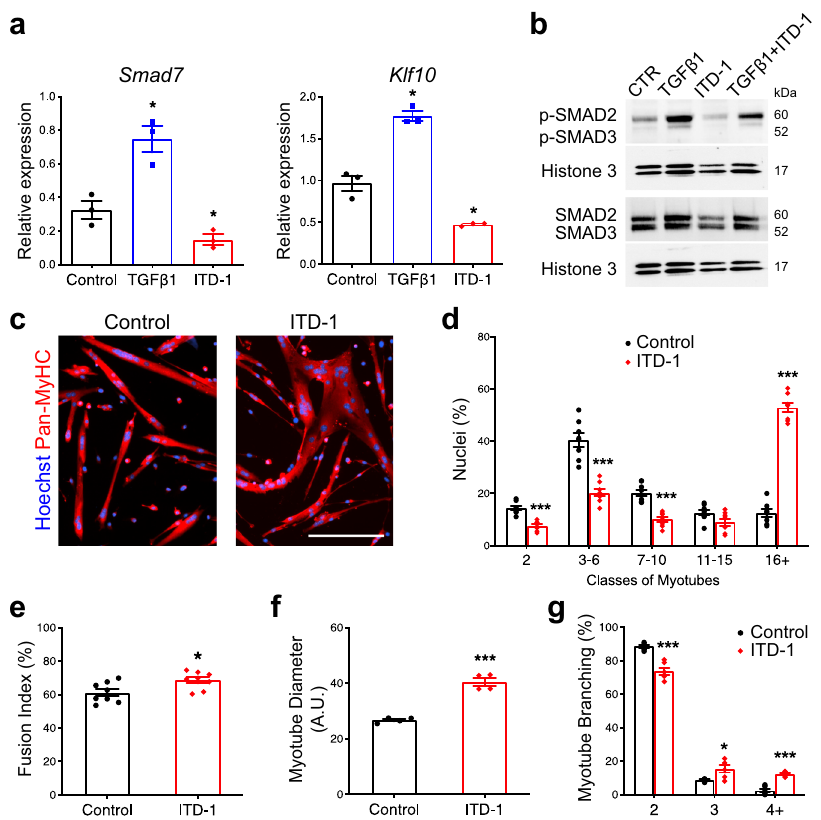
Fig. 5 Inhibition of TGFBR2 function in differentiated muscle cell enhances fusion. a qRT-PCR analysis of TGF β target genes transcript expression in primary myocytes treated with TGF β 1 protein or ITD-1 compound proves that Smad7 and Klf10 are over-expressed when the signaling pathway is activated and inhibited when TGF β cascade is blocked. N = 10 (Control), 8 (TGF β 1), and 8 (ITD-1) biologically independent experiments. b Nuclear p-SMAD2/3 and SMAD2/3 western blot analysis of primary myoblast treated with TGF β 1 protein, ITD-1 compound, or both combined. The intracellular mediators SMAD2/ 3 are phosphorylated upon TGF β stimulation, while ITD-1 is able to reduce their phosphorylation. N = 3 biologically independent experiments. c Immuno fl uorescent staining for Pan-MyHC of re-plated myocytes cultured for 48 h. N = 8 primary cell cultures. d Aggregation index of re-plated myocytes shows that ITD-1 treatment leads to the formation of myotubes with higher numbers of nuclei compared to the control. N = 8 biologically independent experiments. e Fusion index of re-plated myocytes con fi rms the enhanced fusion when TGF β cascade is inhibited. N = 8 biologically independent experiments. Diameter of re-plated myotubes ( f ) and of the distribution of branched-myotubes ( g ) of re-plated cells highlight aberrant morphology of syncytia treated with ITD-1 N = 4 ( f ) and 6 ( g ) biologically independent experiments. Scale bars: c 200 μ m. Data are presented as mean ± SEM. Unpaired two-tailed Student ’ s t tests were used to compare between data. * and *** denote a signi fi cant difference with Control group of P < 0.05 and P < 0.001, respectively. Source data are provided as a Source Data fi